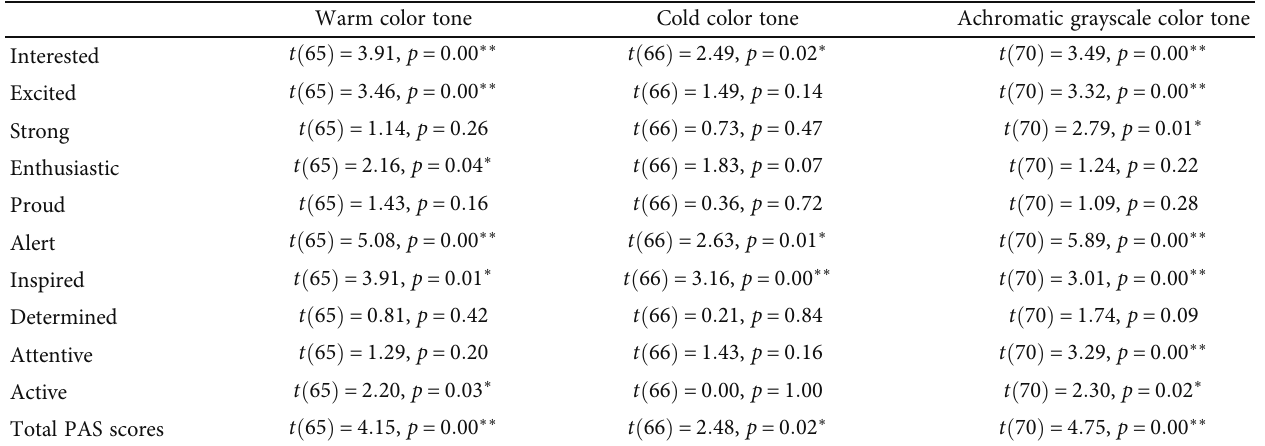
Table 2: Paired samples t -test t -values and p values of each positive emotion type and total Positive A ff ect Scale scores for the e-learning color tones. Warm color tone Cold color tone Achromatic grayscale color